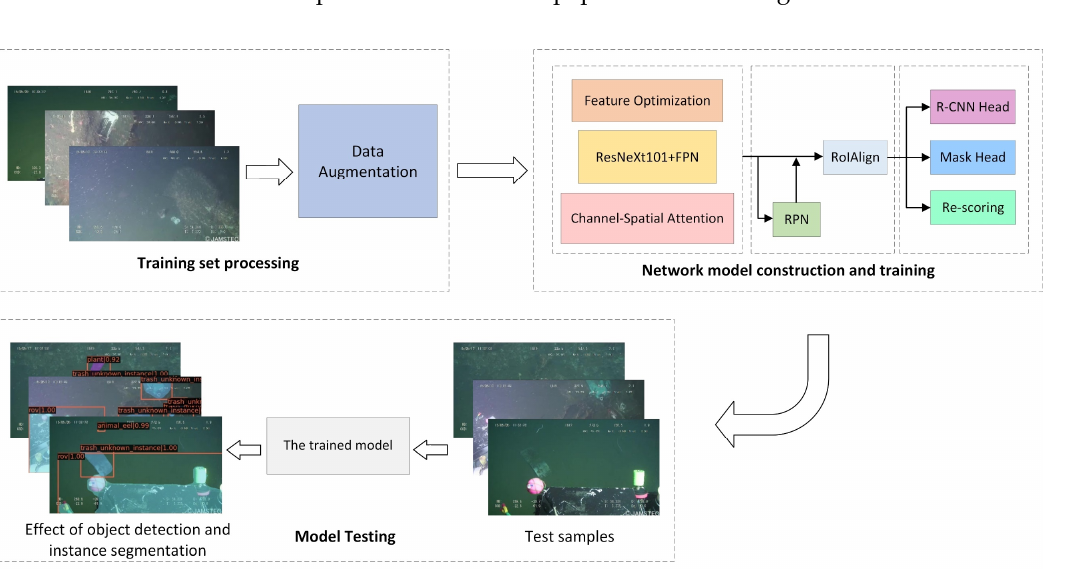
Figure 8. Experimental procedure.